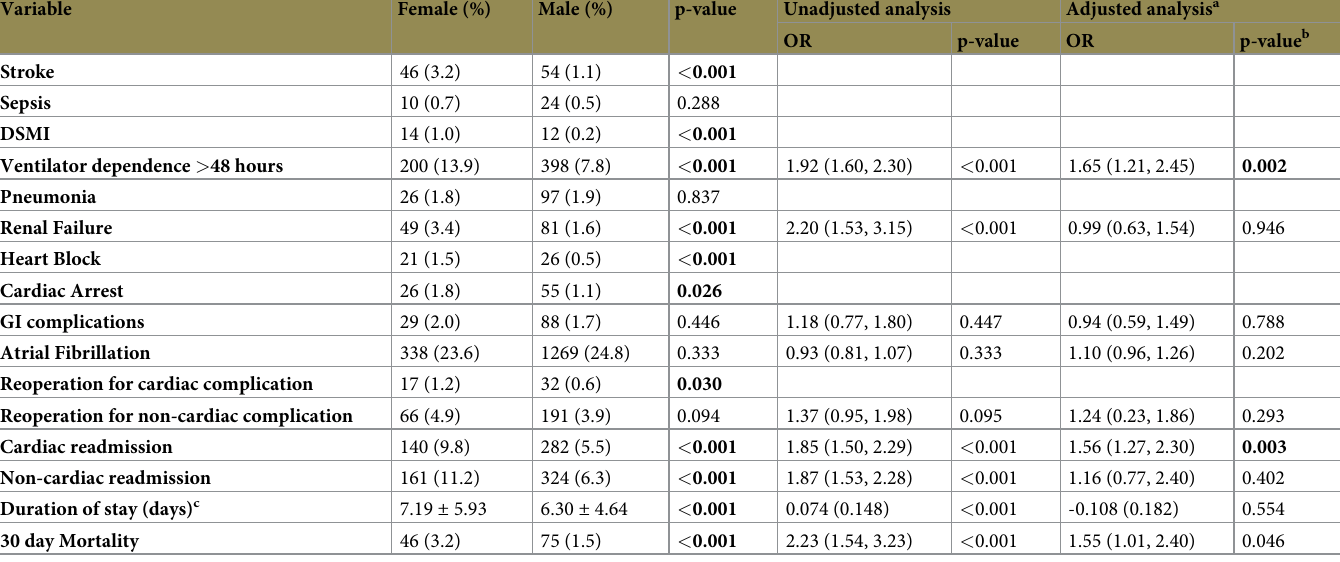
a Adjusted for, obesity, smoking status, diabetes, hypertension, history of myocardial infarction, heart failure, pre-operative ejection fraction and IABP use, heparin and anti-platelets, number of diseased vessels, IMA utilization, number of arterial and venous grafts and year of surgery. b Bonferroni correction applied for multivariable regression—p < 0.0045 considered significant. c Results of Linear regression analysis reported as standardized coefficient (coefficient standardized